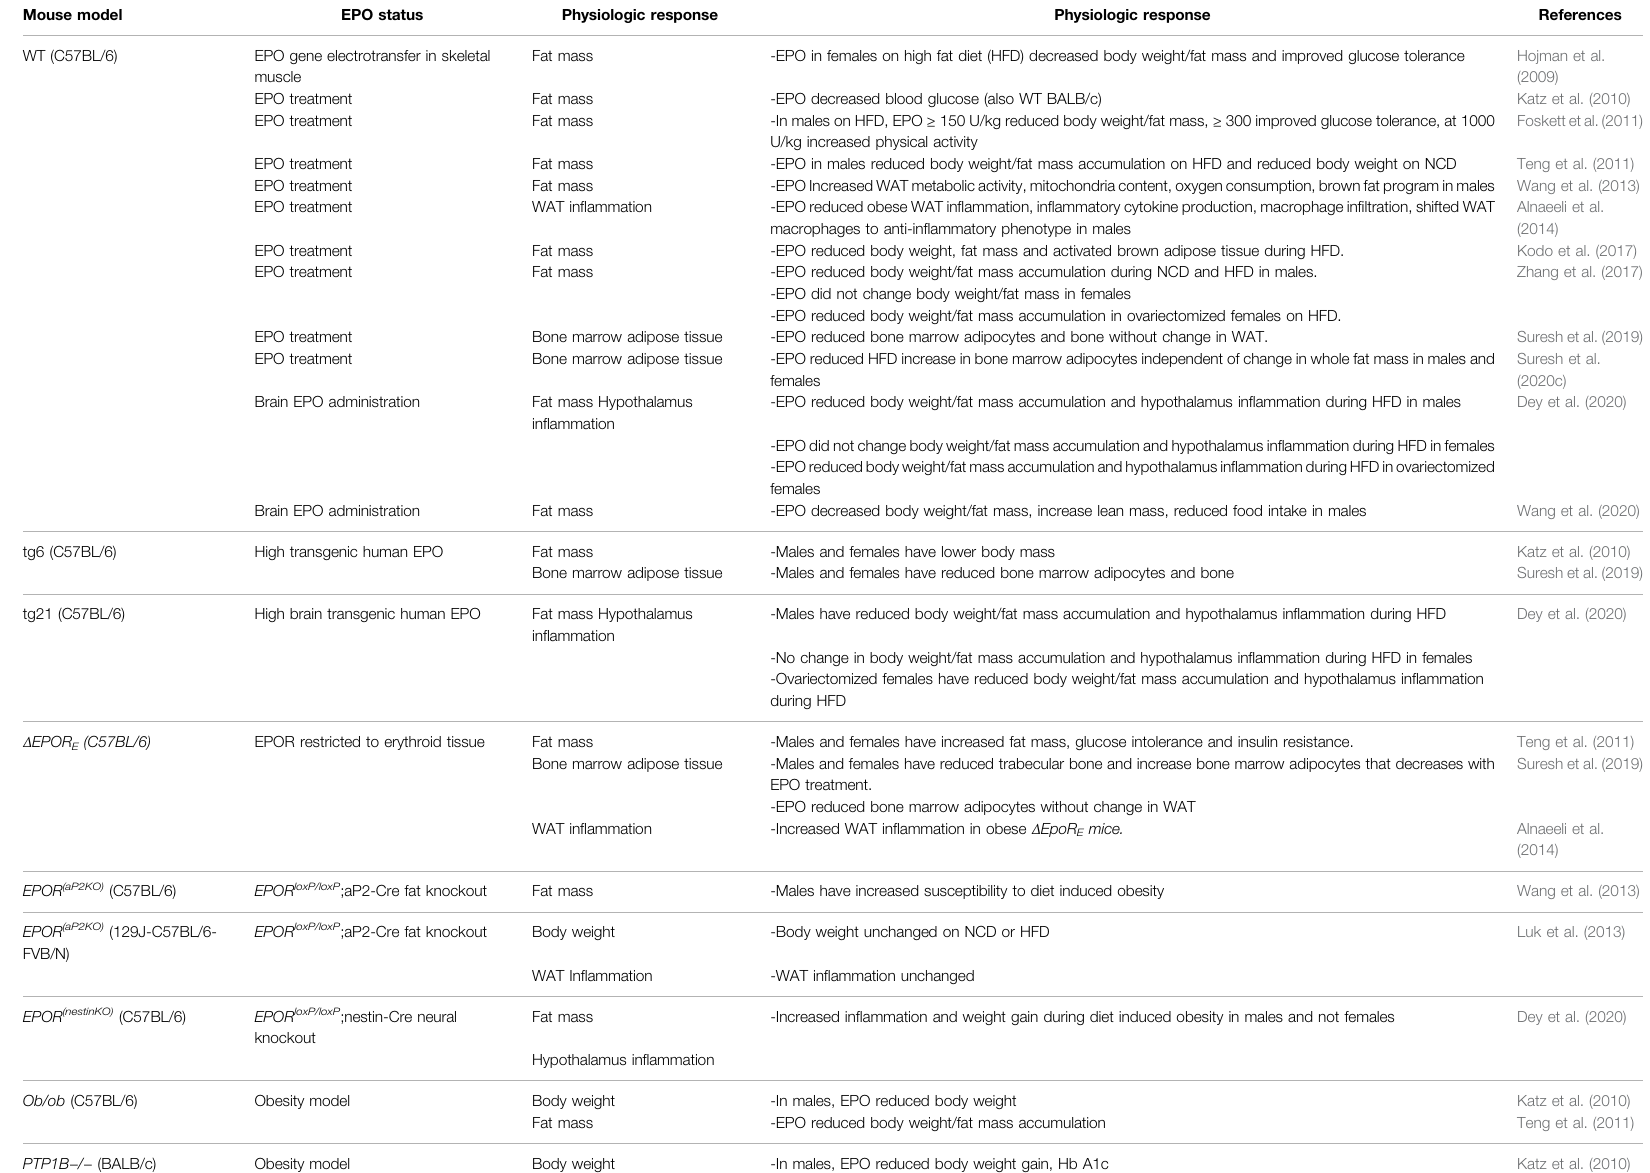
TABLE 1 | Erythropoietin regulation of fat mass and in fl ammation in mice during diet induced obesity. Mouse